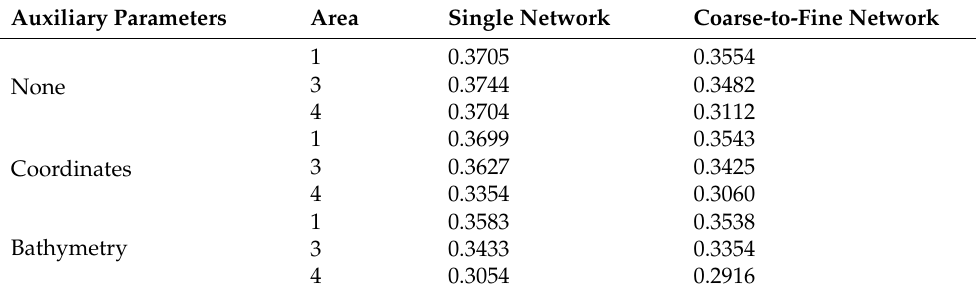
Table 2. RMSE between ln ( Chl-a rec ) and ln ( Chl-a obs ) of the models in the test set. Auxiliary Parameters Area Single Network Coarse-to-Fine Network